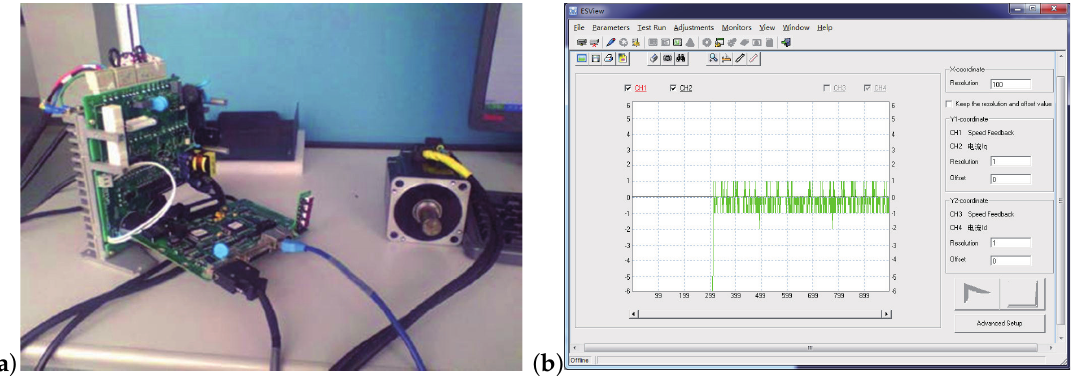
Figure 3. The experiment platform: ( a ) the tested IPMSM servo system; ( b ) the software interface of the upper